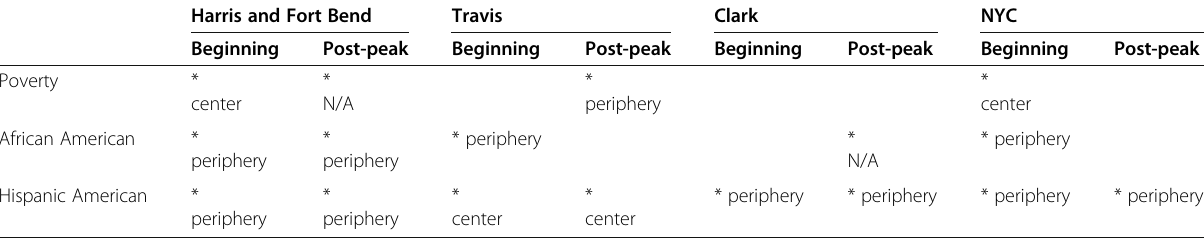
Table 3 Summary of multiple-model